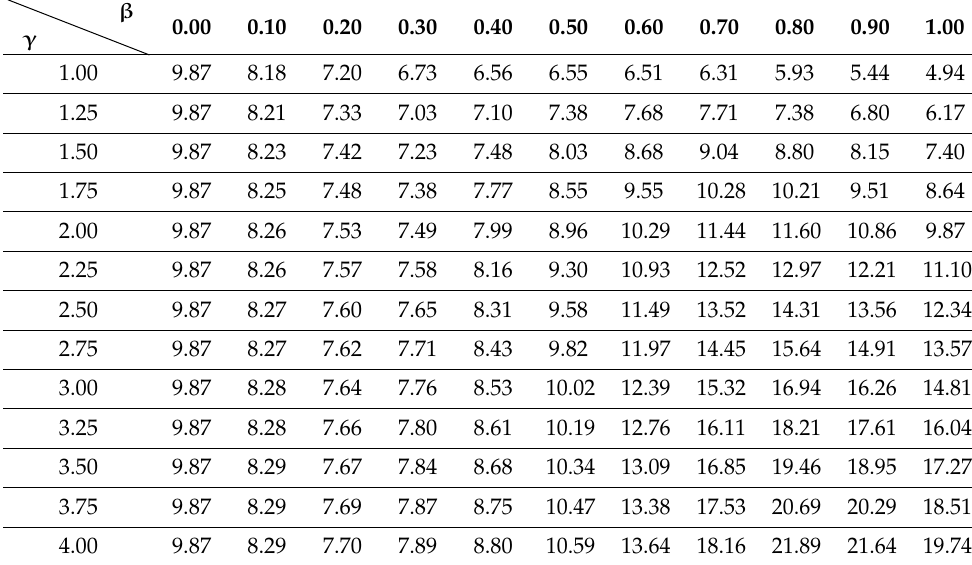
Table 4. Values P g /P d for α = 1.0 and for different values of β and γ .